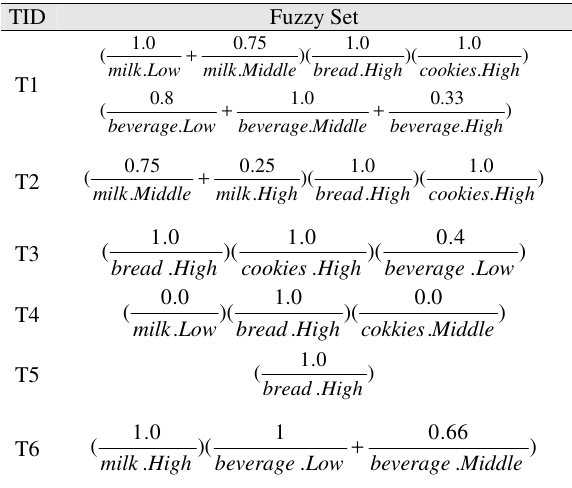
Table 2. The transformed fuzzy